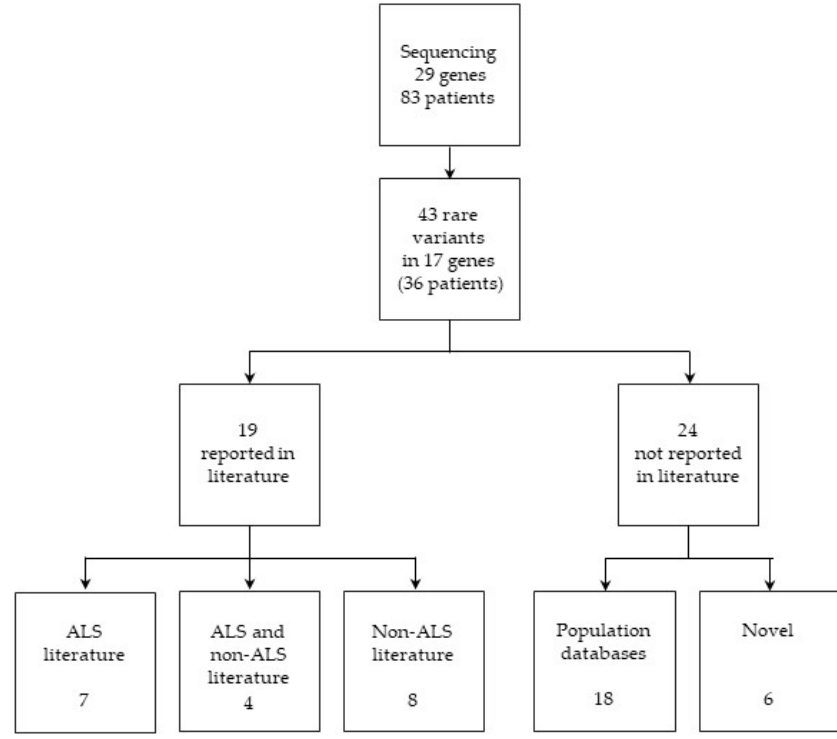
Figure 1. Variant identification and classification.